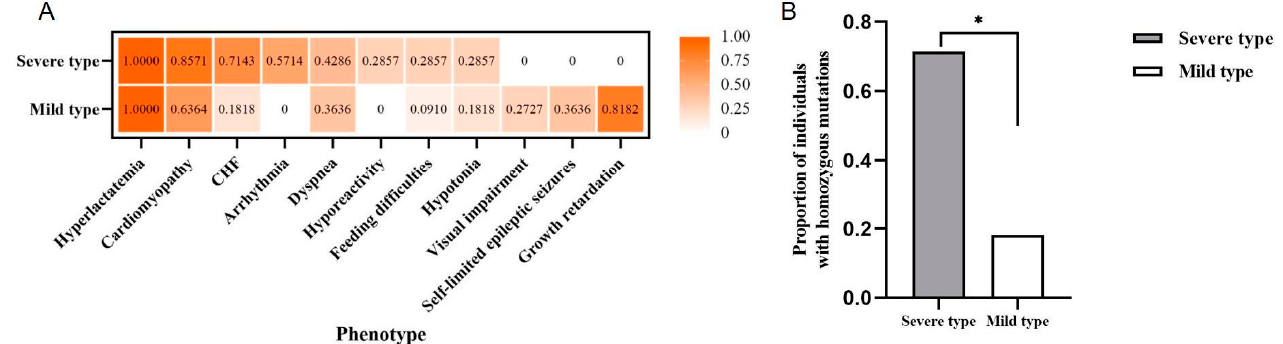
Figure 3. Comparison of phenotypes and variant types between severe and mild patients. ( A ) Com- paring the frequencies of different phenotypes within two types of patients ( n = 18); it was found that there were significant differences in the frequencies of developmental delay ( p = 0.0023 **), ar- rhythmia ( p = 0.0114 *) and CHF ( p = 0.0491 *); ( B ) Comparing the proportion of individuals carrying homozygous variants in the two types of patients ( n = 18), the proportion in severe patients (5/7, 71.43%) was significantly different from that in mild patients (20/225, 18.18%) ( p = 0.0491 *). CHF: congestive heart failure. * <